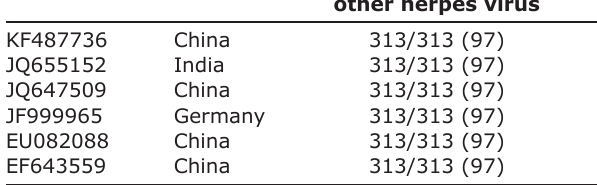
Table-3: Homology of DNA polymerase gene (Accession No. HG425076) sequence of DEV with other herpes virus gene sequences available in